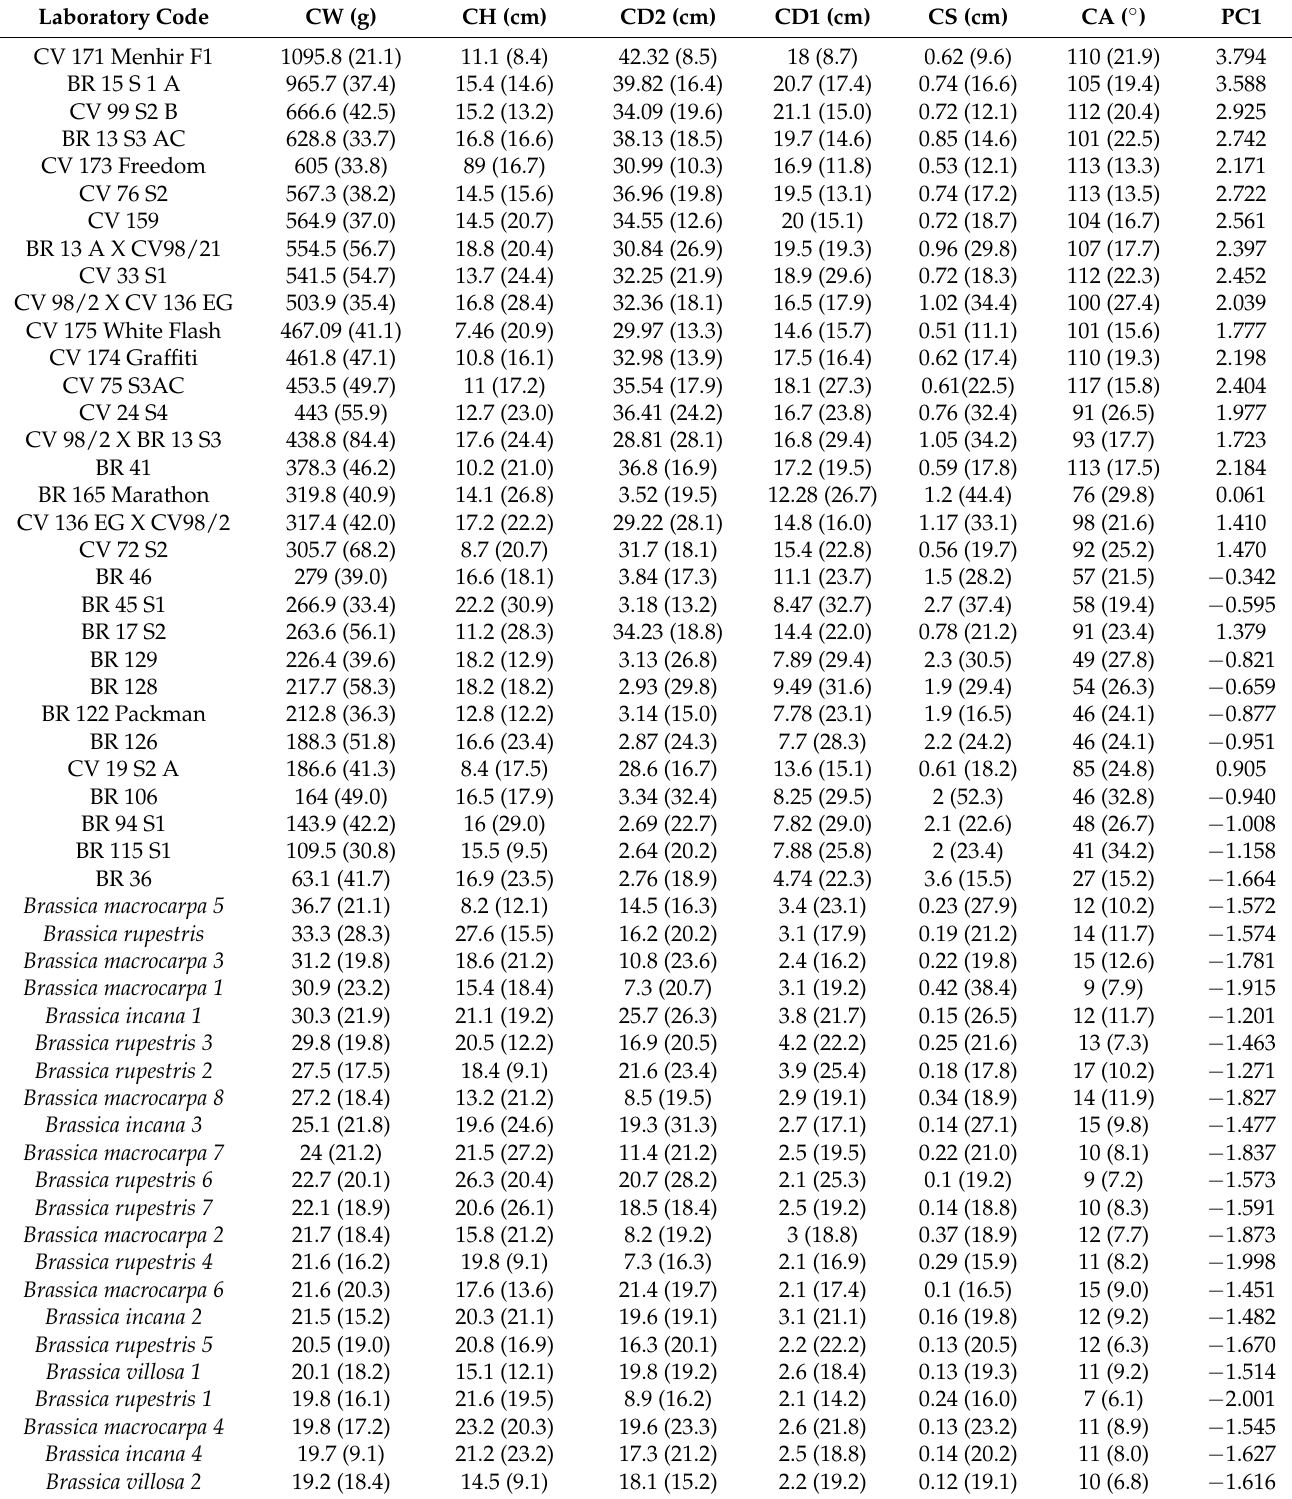
Table 3. Inflorescence morphometric characteristic in descending order, from the heaviest to the lightest. The parameters measured were curd weight (CW), height (H), curvature angle (CA), curd and stem diameters (CD1 and CD2) and principal component 1